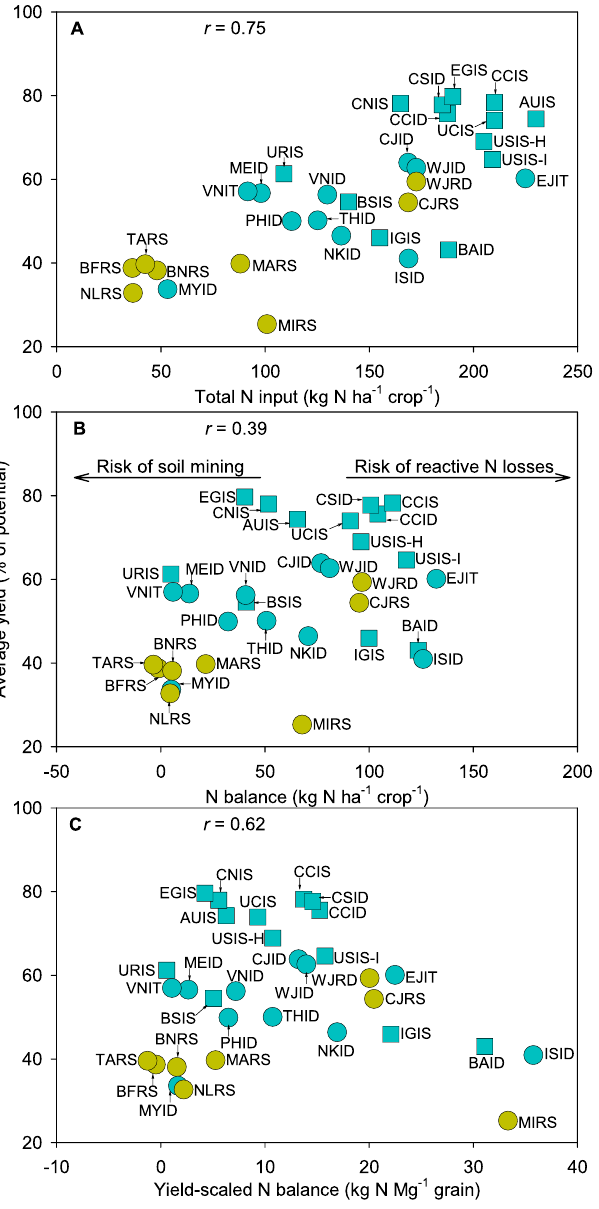
Fig. 3 Yield, nitrogen (N) input and N balance across 32 rice cropping systems. Panels show average rice yield (expressed as percentage of yield potential) versus A total N input (from fertilizer, manure, and fi xation), B N balance calculated as N input minus N removal, and C yield-scaled N balance. Symbol type and color are used to distinguish tropical versus non- tropical regions (circles and squares, respectively) and irrigated versus rainfed systems (blue and yellow, respectively). Pearson ’ s correlation coef fi cient ( r ) is shown only when the association between variables is signi fi cant (two-tailed Student ’ s t -test; p < 0.01; n = 32 cropping systems). Cropping system codes are shown in the caption to Fig. 1. Data are provided in Source Data. relatively large N balance (>100 kg N ha − 1 ) and yield-scaled N balance (>15 kg N Mg − 1 grain), suggesting room for reducing N input and N balance without yield penalty.